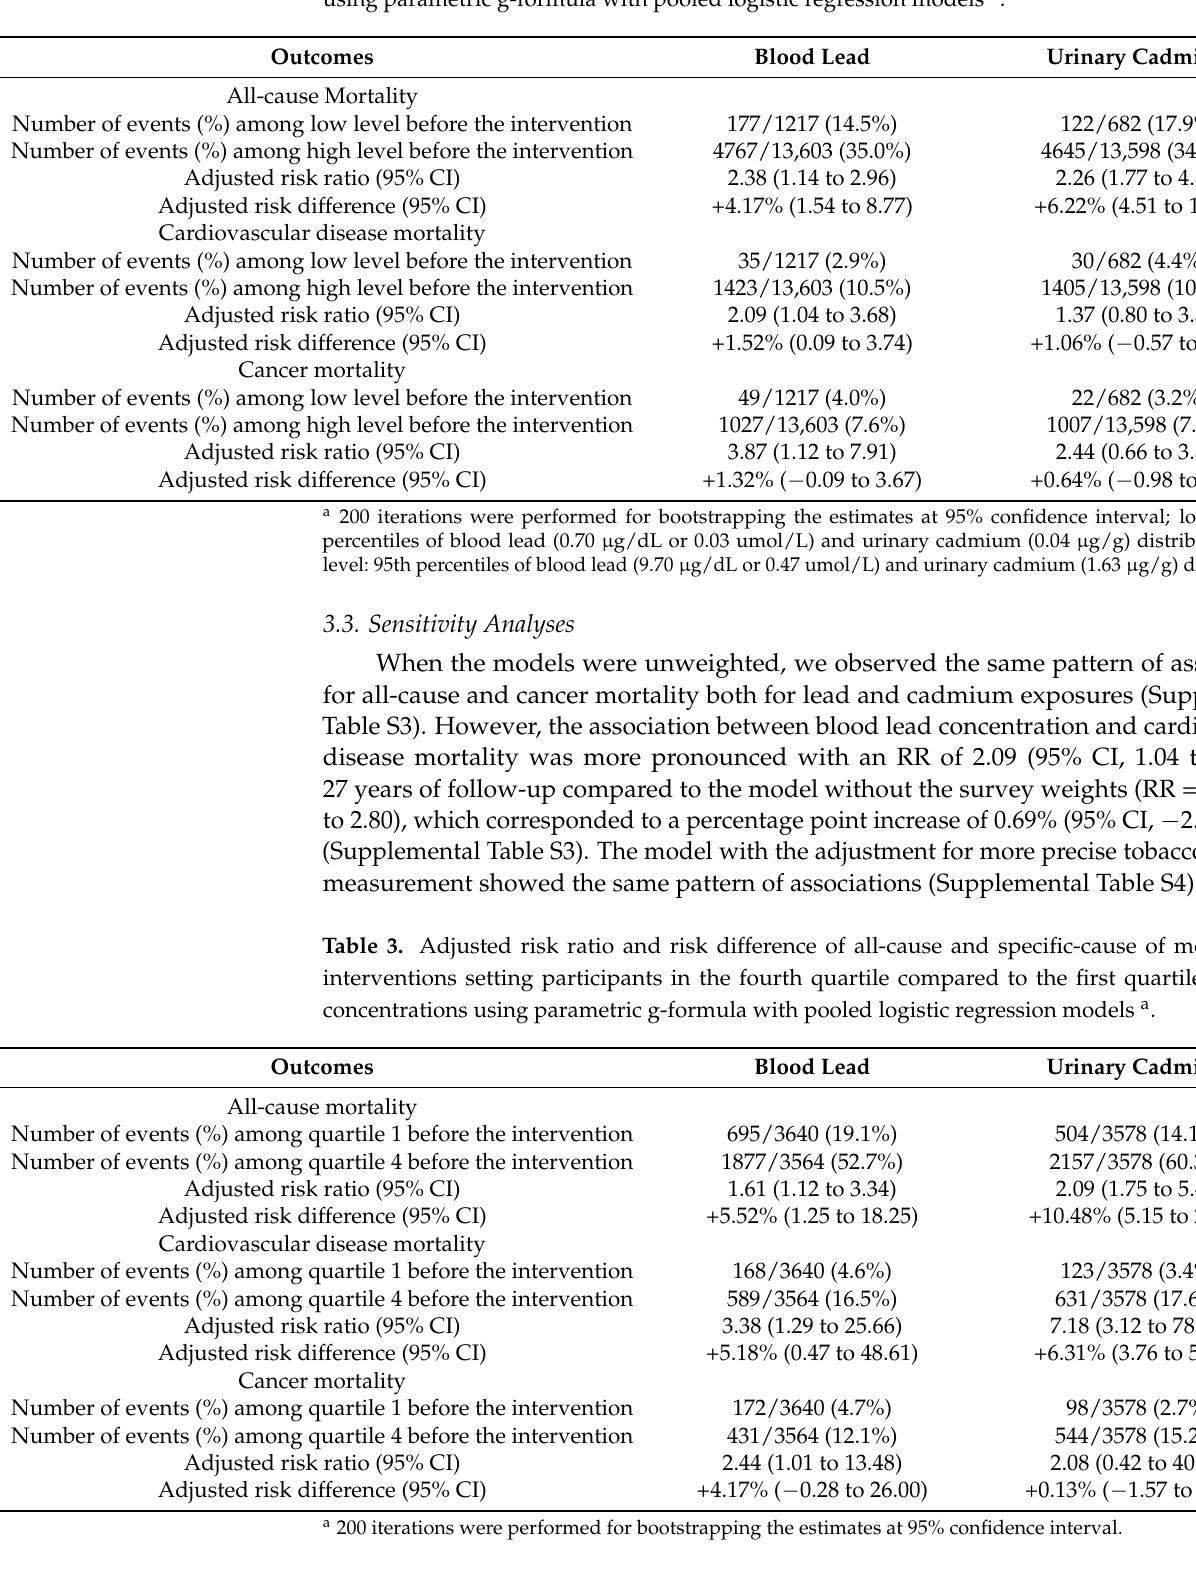
Table 2. Adjusted risk ratio and risk difference of all-cause and specific-cause of mortality for inter- ventions assigning 95th percentile values compared to 5th percentile values of metal concentrations using parametric g-formula with pooled logistic regression models a .